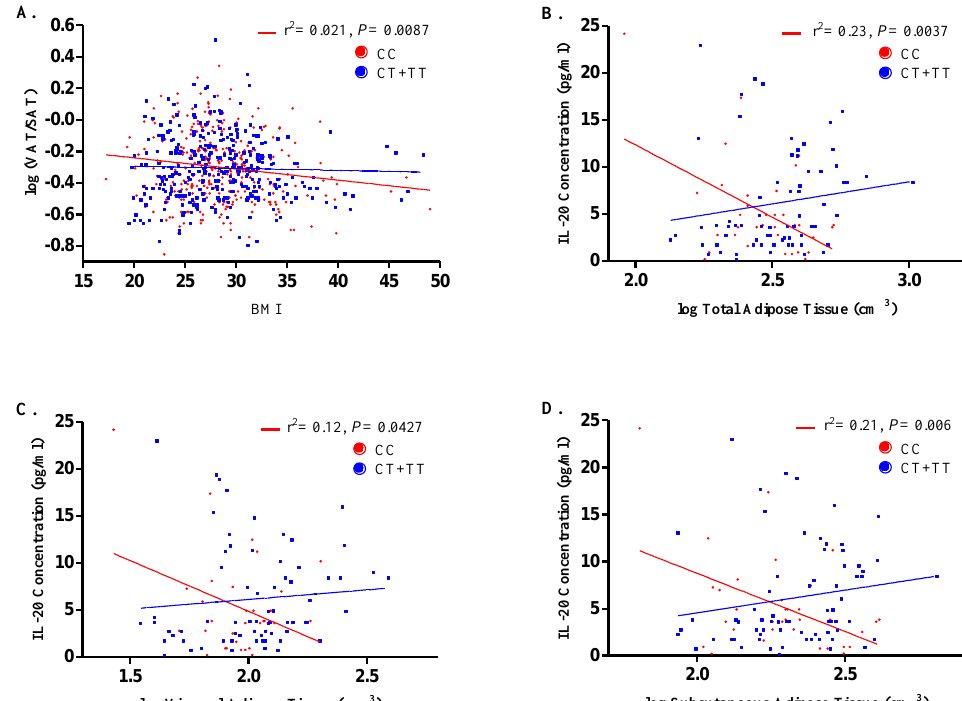
Figure 2. Correlation between adipose tissue distributions, body mass index and IL-20 concentrations according to rs1400986 genotypes in control individuals. Lines represent simple linear regression: blue lines represent CT + TT genotypes carriers and red represent CC genotype carriers. ( A ) Overall, body mass index (BMI) was negatively correlated with visceral to subcutaneous adipose tissue ratio (VAT / SAT) in individuals with CC genotypes but not in individuals with CT + TT genotypes. On adipose tissue stratification, a negatively and significant correlation of IL-20 levels and log TAT ( B ), log VAT ( C ) and log SAT ( D ) was observed in individuals with CC genotypes.